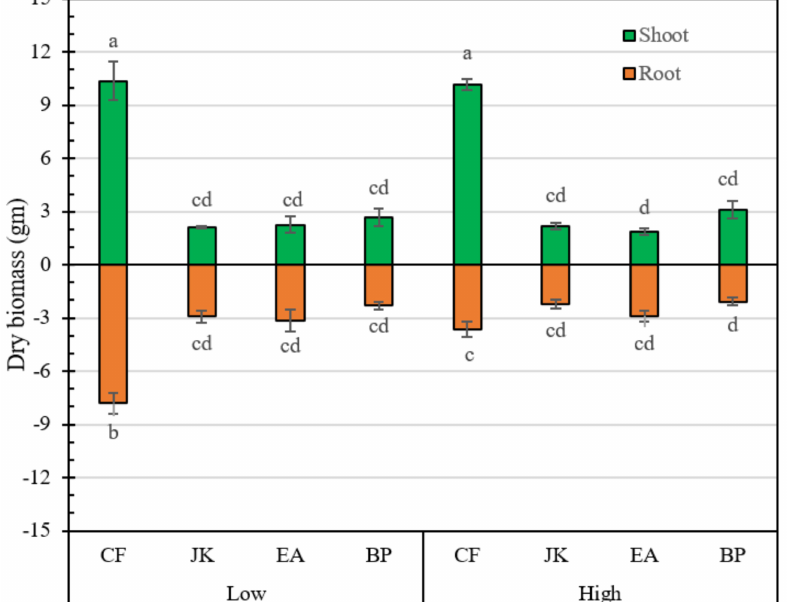
Figure 6. Final dry biomass of plants at the end of experiments. Error bars are standard errors. One–way ANOVA with Duncan post-hoc analysis was performed. Values sharing a common letter label are not statistically